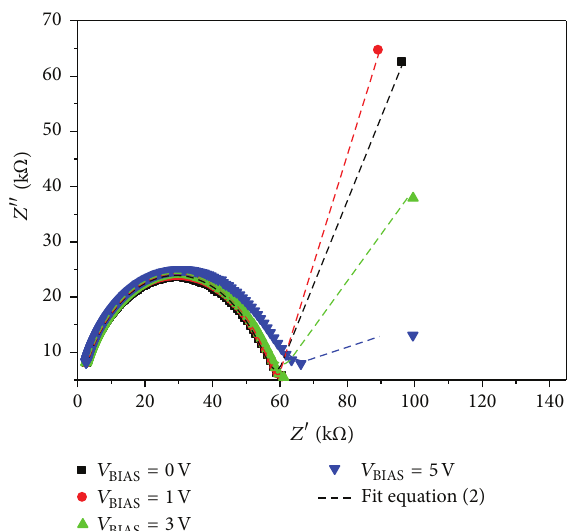
Figure 7: Plot of the imaginary part versus real part of the device impedance for gelatin/graphene based device, measured for four different bias voltages in a frequency range between 100Hz and 100 KHz at room temperature. Dotted line curves are the best fit of the measured impedance with